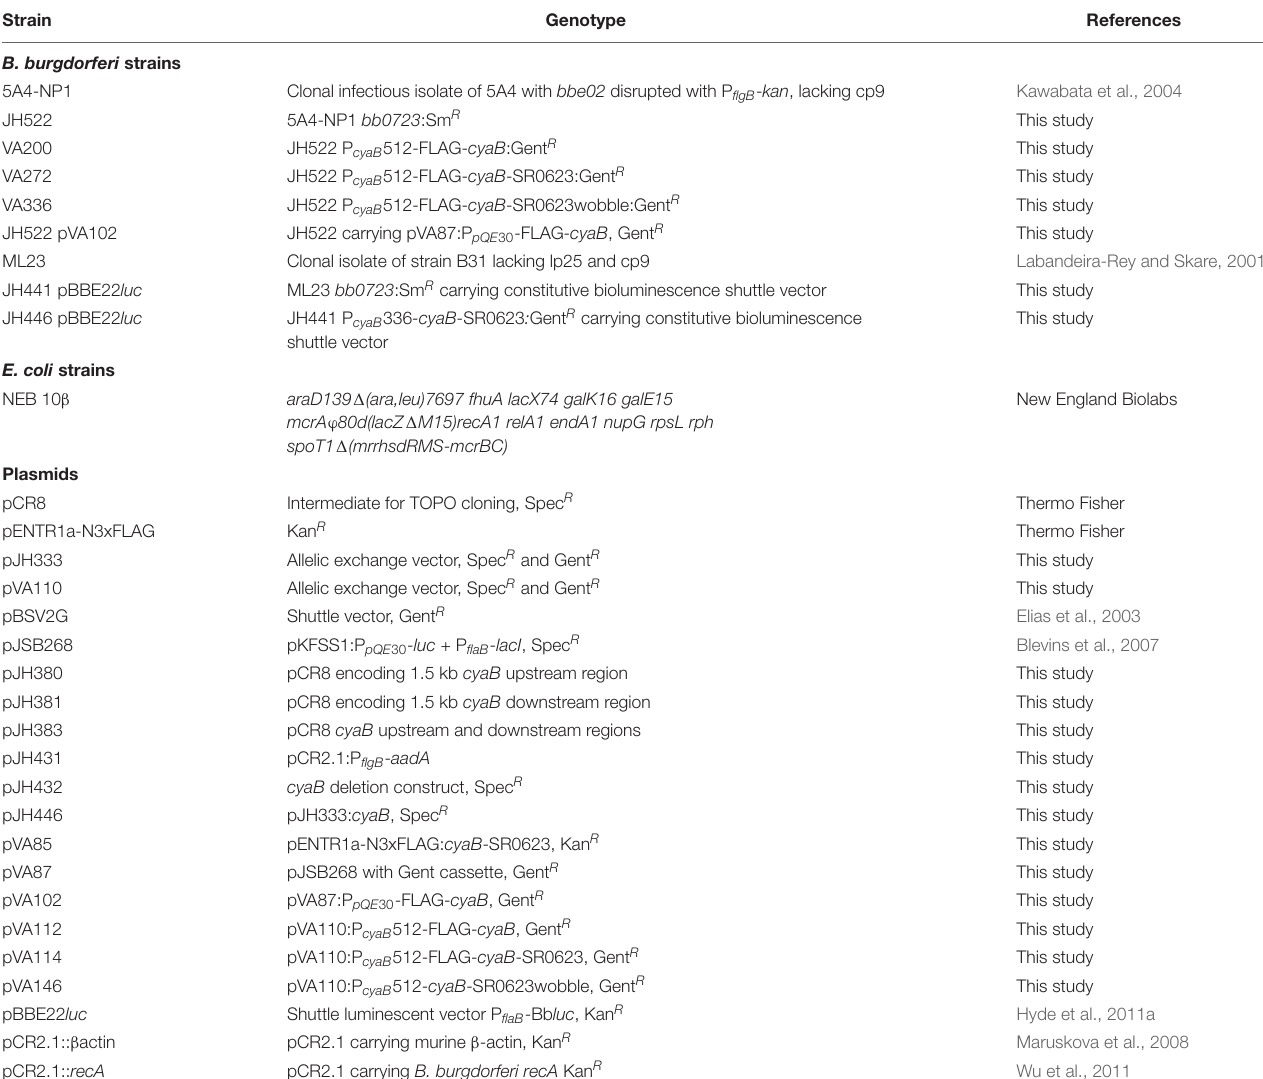
TABLE 1 | Strains and plasmids used in this